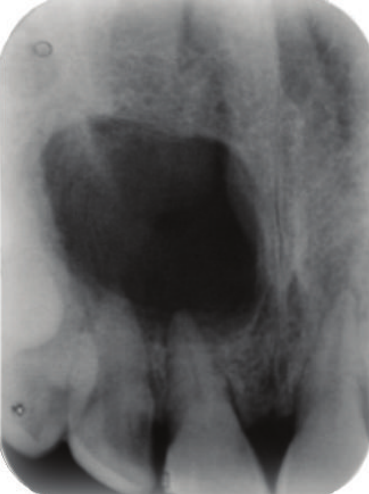
Figure 3: Pre-operative IOPA radiograph showing well-defined large periapical lesion.